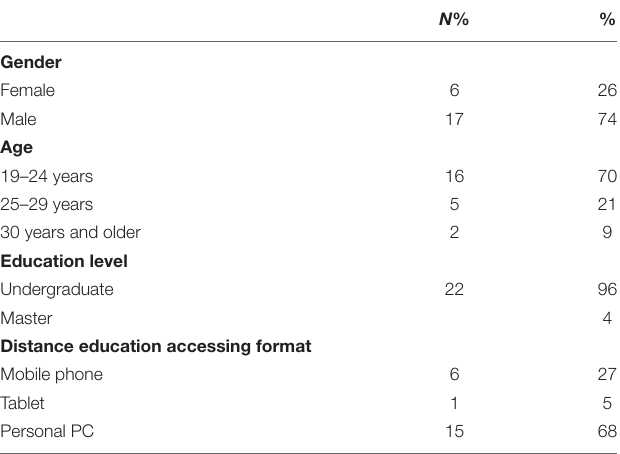
TABLE 1 | Demographic and communication tools used distribution of